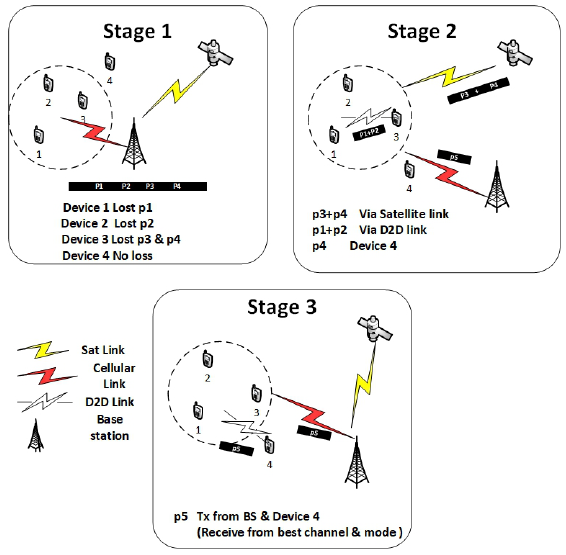
Figure 4. Multiple Access Network Coding